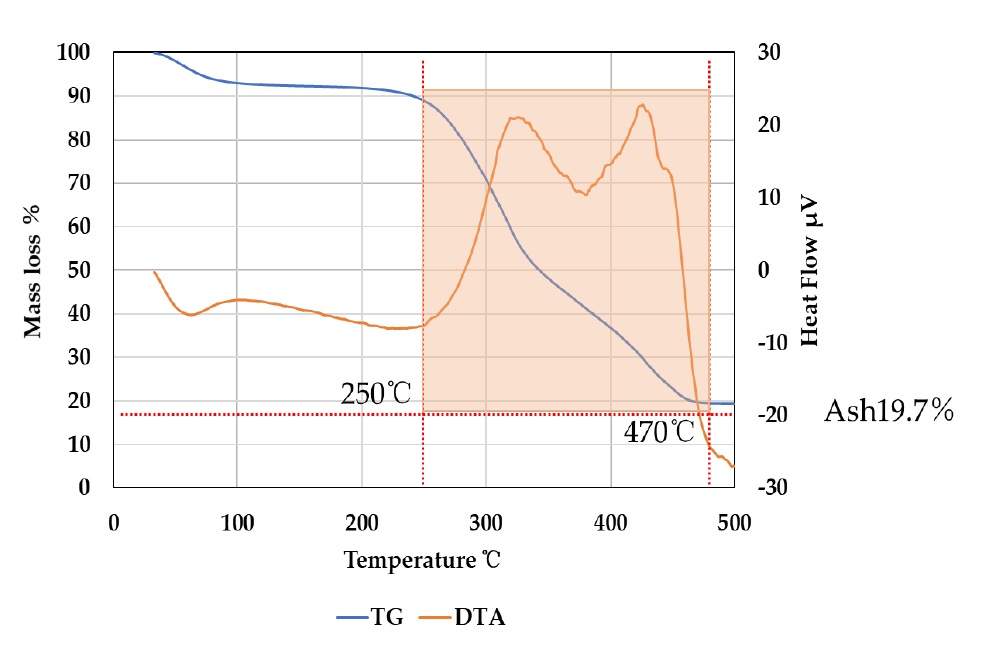
Figure 12. TG / DTA analysis results of raw rice Figure 12. TG/DTA analysis results of raw rice husks.